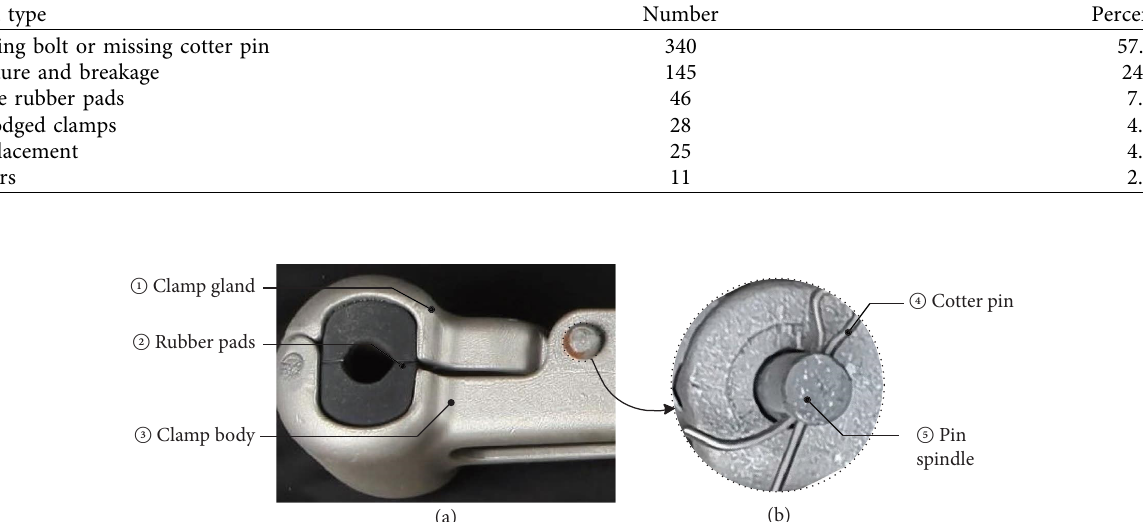
Table 1: Statistical data of the damage of spacer damper.